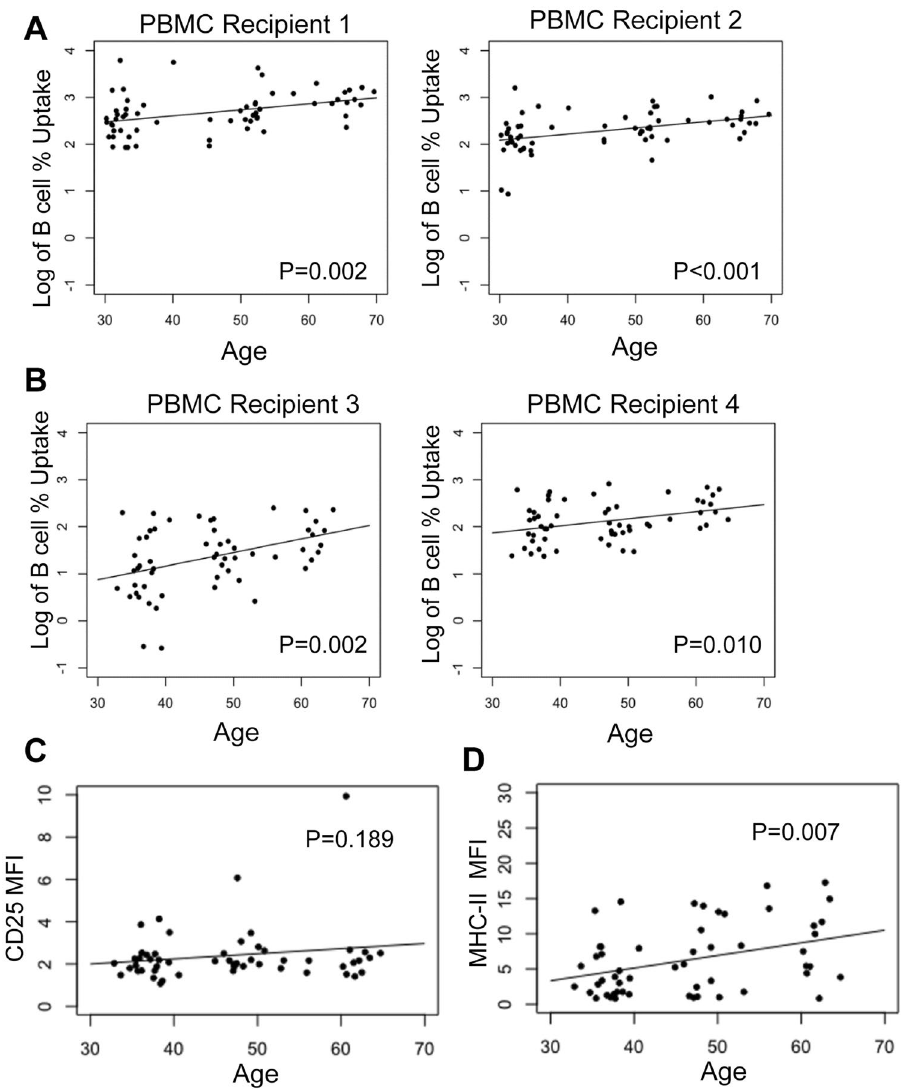
Figure 3. B Cells internalize older EVs more readily. ( A ) EV plasma samples (n = 62; 2.00 E + 08 particles) from young, middle-aged and older individuals were incubated with 1 old (1) and 1 young (2) PBMC recipient. ( B ) In a separate experiment, EV plasma samples (n = 57) from young, middle-aged and older individuals were incubated with a different old (3) and young (4) PBMC recipient. In both experiments, EVs were incubated with PBMCs for 24 hours and then anayzed by FACS. The points are the actual data (log transformed) and the line is from the model accounting for matching. ( C ) CD25 Mean Fluorescence Intensity (MFI) in B cells that interacted with EVs (CD19 + PKH + CD25 + ) was plotted against the EV donor age. ( D ) MHC-II MFI in monocytes that interacted with EVs (CD11b + PKH + MHC-II + ) was plotted against EV donor age. The graphs in C-D are 57 EV donors that were incubated with PBMC recipient 3. For all graphs, linear mixed model regression was used to analyze the relationships accounting for both sex and race matching and P values are